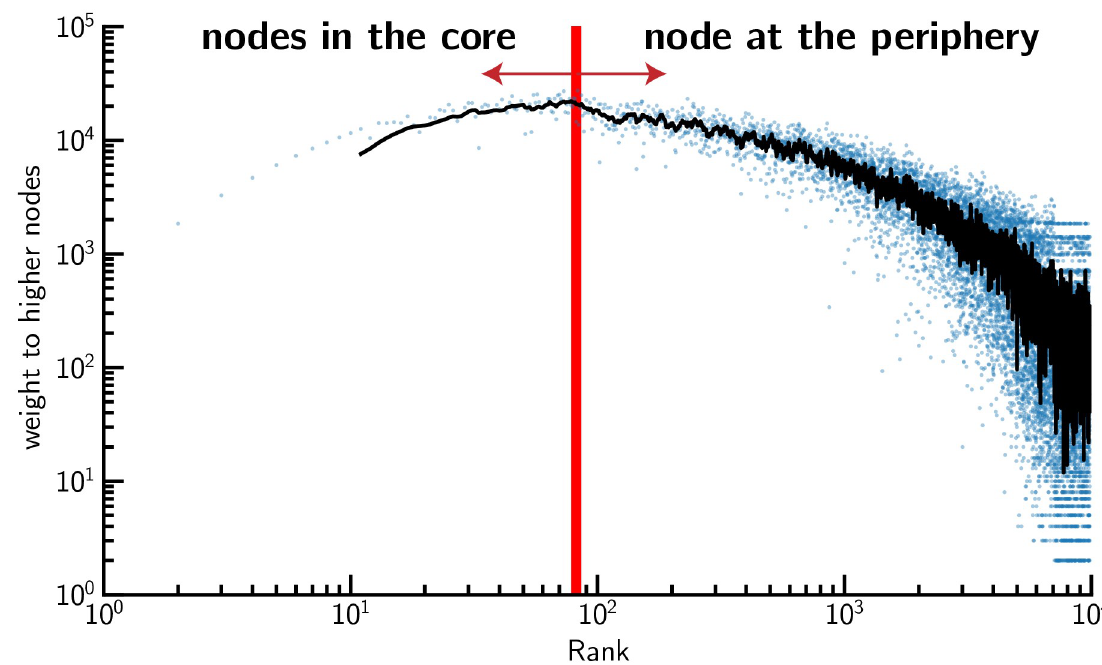
Fig 14. Example of core/periphery detection for the weighted directed network. Here the core/periphery of a slice of the transaction graph of May 2, 2017 is displayed. The core size is | V